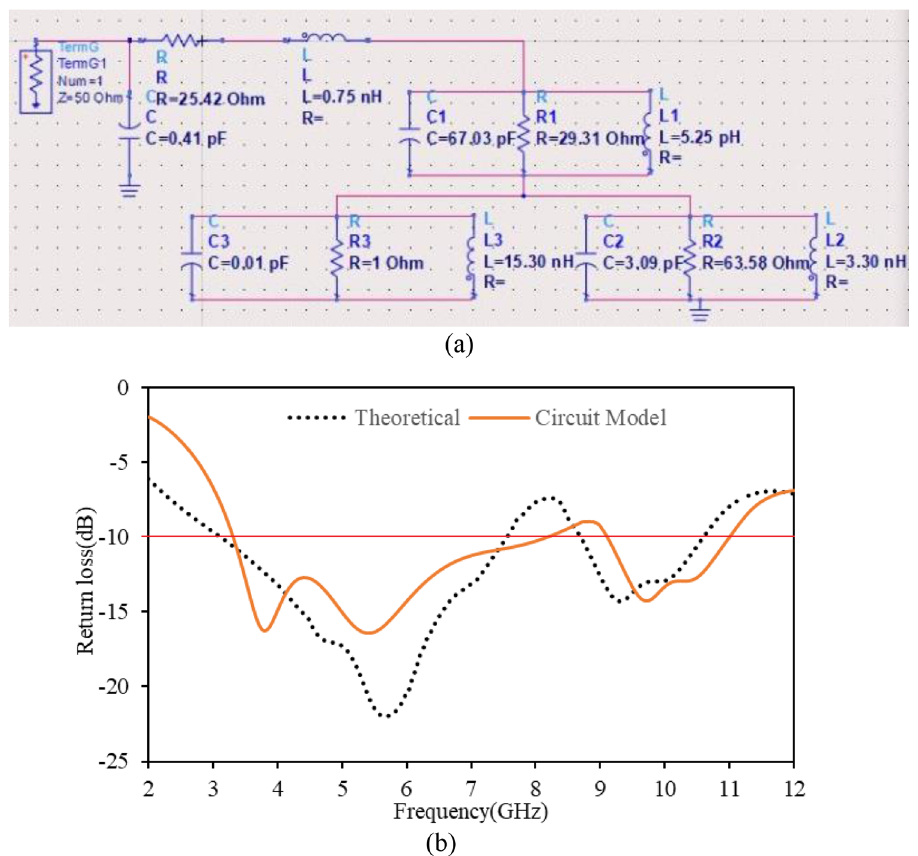
Figure 2. ( a ) Lumped equivalent circuit model and ( b ) theoretical & circuit model return loss curves of the